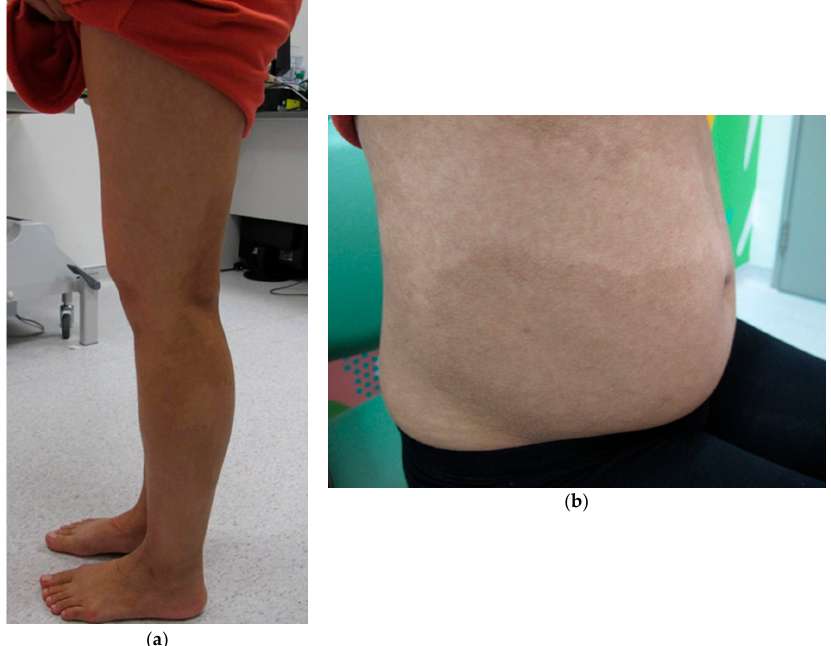
Figure 1. Blanschko’s line is evident on ( a ) the lower limbs and ( b ) over the abdomen; photograph taken when the patient was pregnant at 25 weeks of gestation.